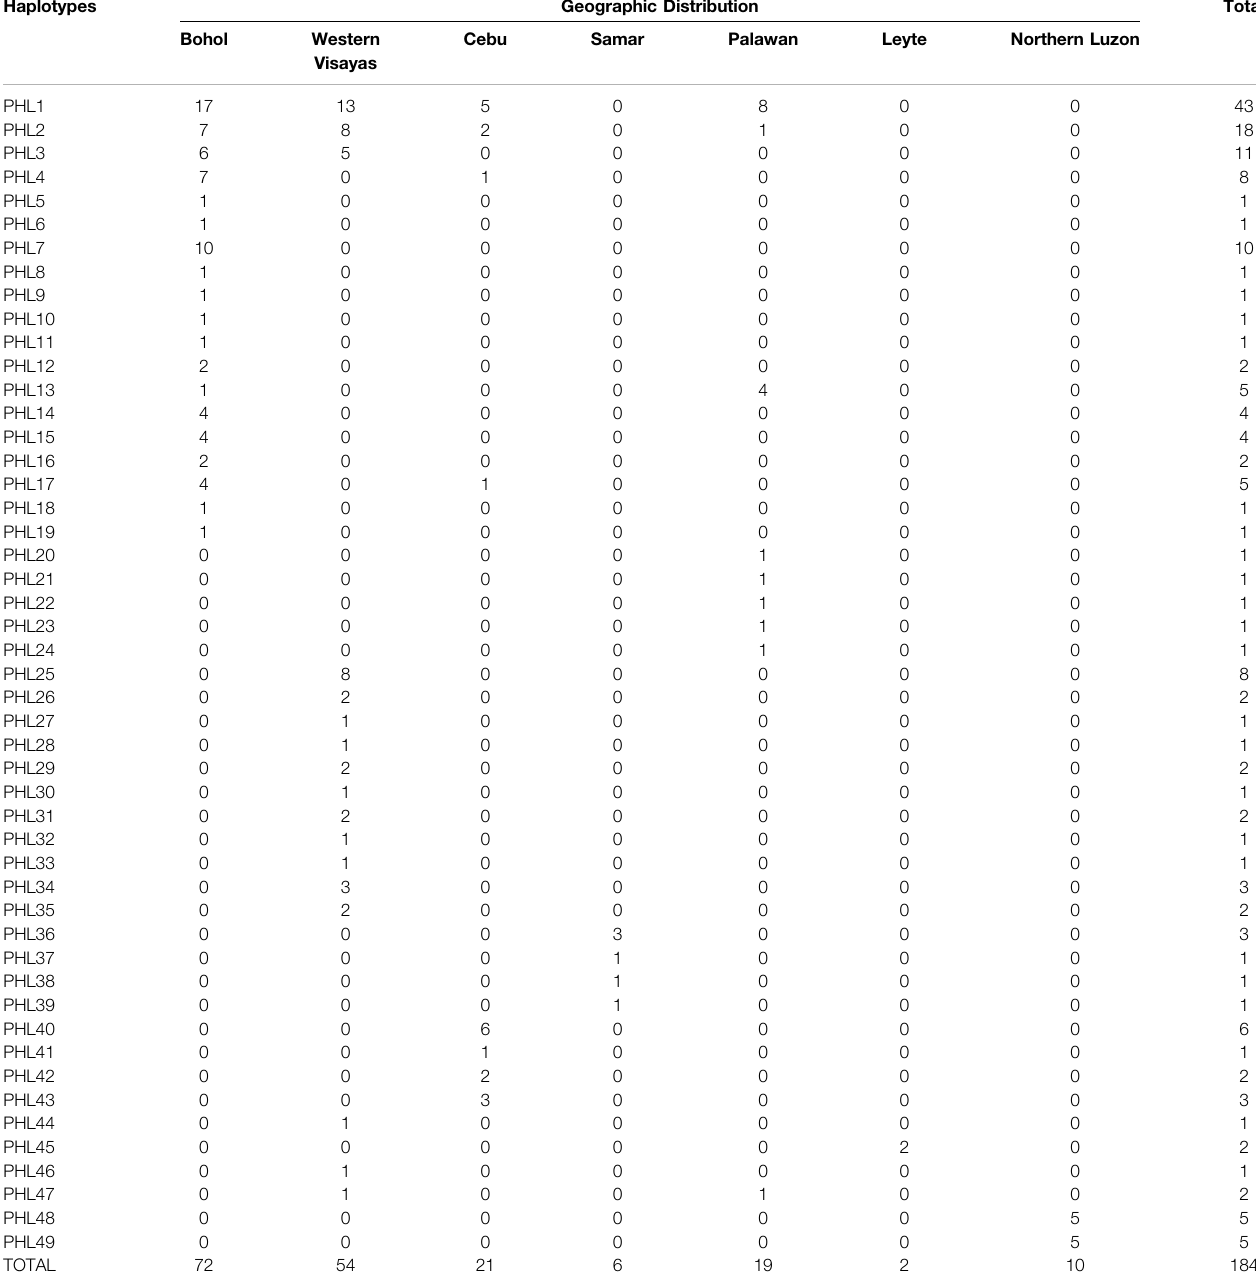
TABLE 1 | List of haplotypes and their geographic distribution. Haplotypes Geographic